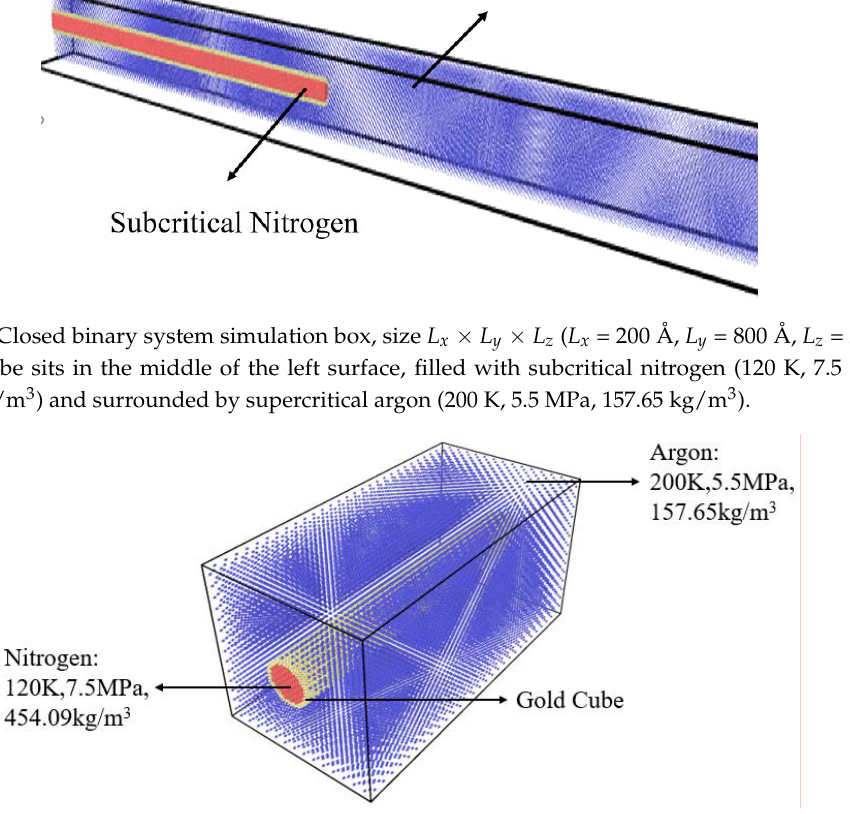
Figure 3. Left section of the simulation box, size L x × L y × L z ( L x = 200 Å , L y = 400 Å , L z = 200 Å ). A gold tube sits in the middle of the box, filled with subcritical nitrogen (120 K, 7.5 MPa, 454.09 kg/m 3 ) and surrounded by supercritical argon (200 K, 5.5 MPa, 157.65 kg/m 3 ).